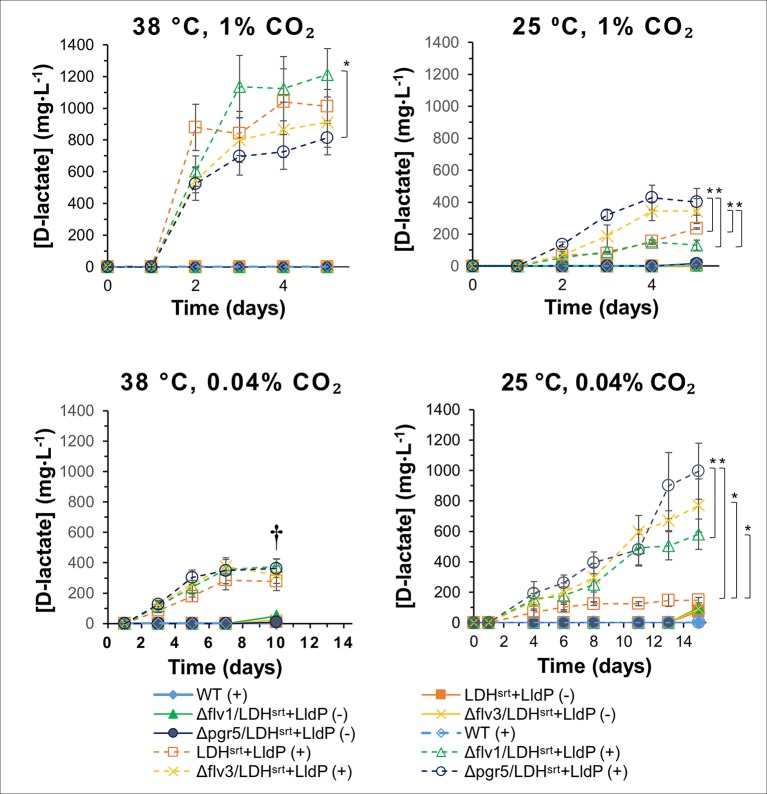
D-lactate production in several electron transport single mutants under different growth conditions. D-lactate concentrations in culture supernatants were measured at the time points indicated, in the absence (-) or presence (+) of 0.5 mM IPTG. Error bars indicate a 95% confidence interval based on the standard error of the mean for triplicate cultures. Asterisks denote statistically relevant differences between indicated strains. † - Culture death.